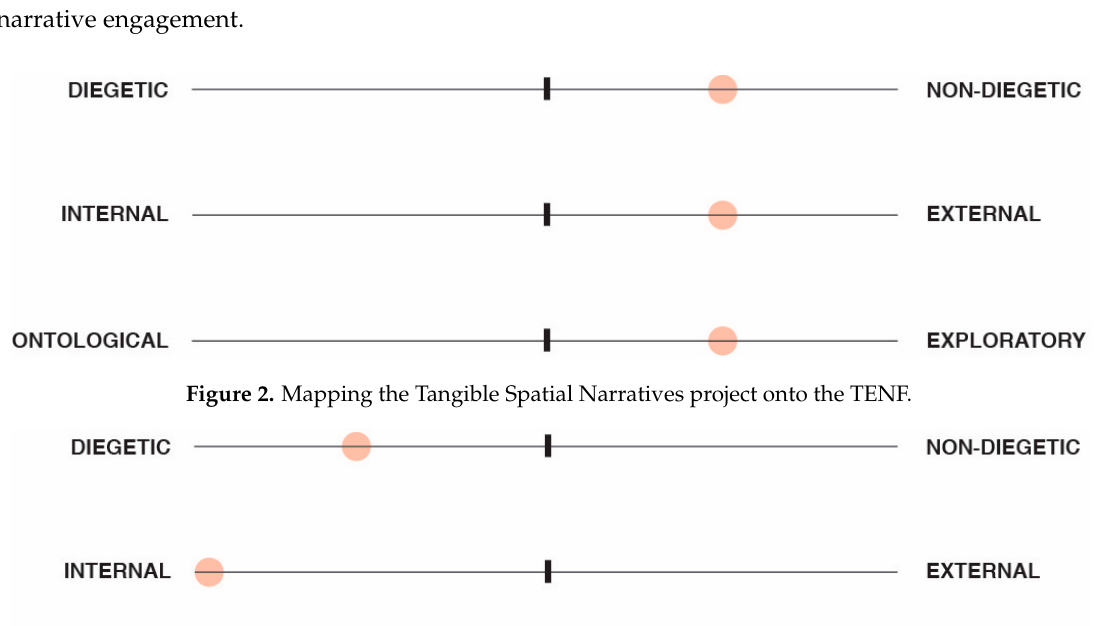
Figure 3. Mapping the Nintendo Wiimote game console device onto the TENF.